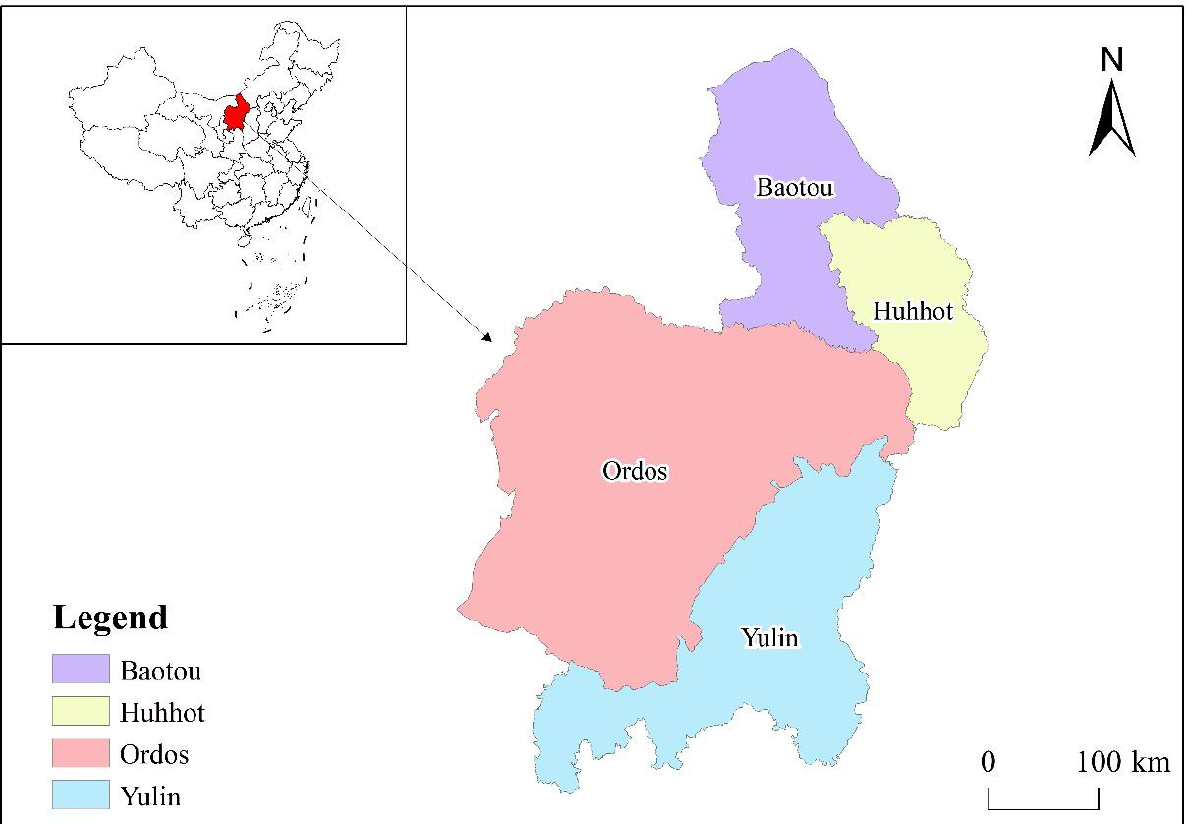
Figure 1. Location of the Hu-Bao-O-Yu urban agglomeration.